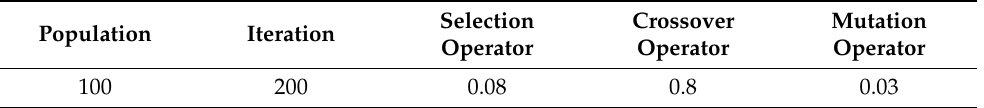
Table 9. Parameters of the